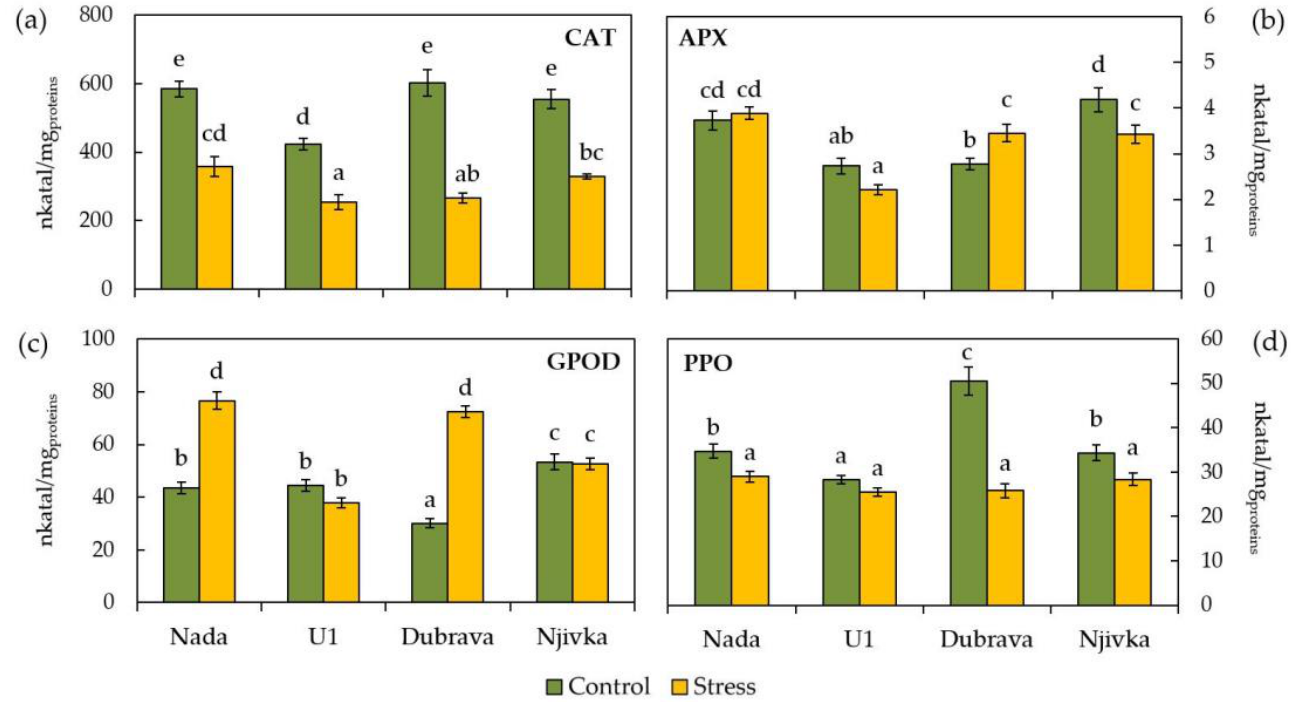
Figure 3. Activities of catalase (CAT) ( a ), ascorbat peroxidase (APX) ( b ), guaiacol peroxidase (GPOD) ( c ), and polyphenol oxidase (PPO) ( d ) in control and drought-stressed flag leaves of wheat cultivars. Bars represent mean values ± SE. Different letters indicate a significant difference among treatments and cultivars at p < 0.05 according to LSD test.